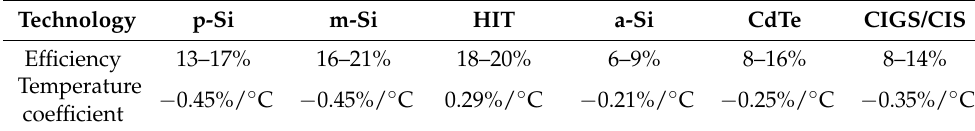
Figure 3. Market share of PV panel technologies in the world in 2016. Table 2. The average efficiency of current PV panel technologies.